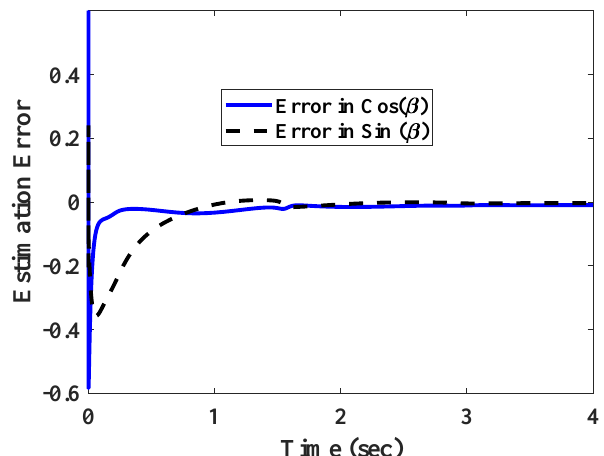
Figure 4. Estimation error in presence of slow varying of measurement errors.